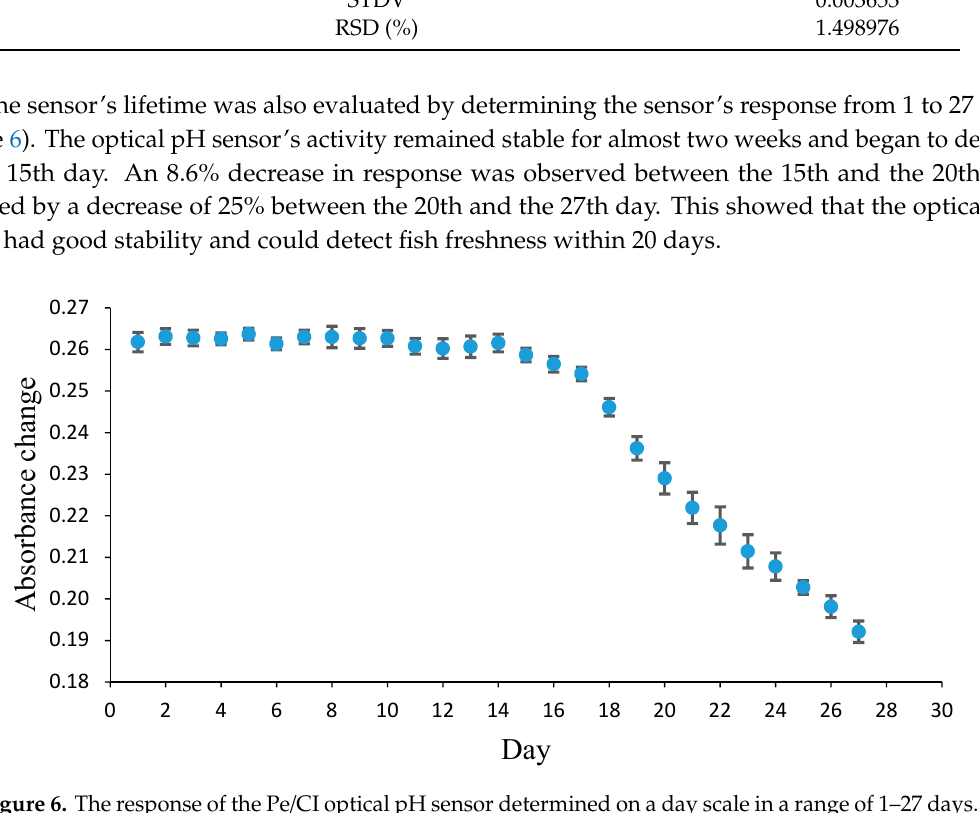
Figure 6. The response of the Pe / CI optical pH sensor determined on a day scale in a range of 1–27 days.